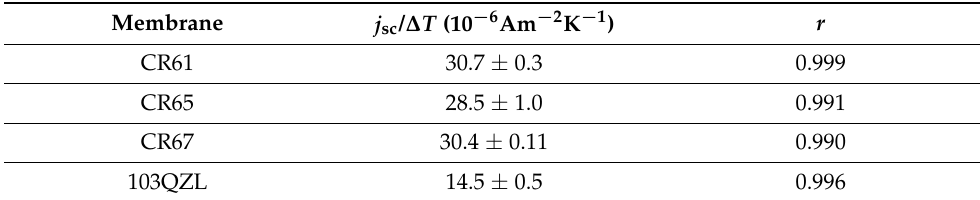
Figure 5. Short-circuit current density versus temperature difference for the different ion-exchange membranes. Electrolyte: 10 − 4 M KCl. Mean temperature: 25 ◦ C. Natural convection. Lines corre- spond to linear fits of the experimental data. Table 2. Short circuit density per K of temperature difference for the different ion-exchange mem- branes. Values correspond to linear fits of the experimental data in Figure 5.